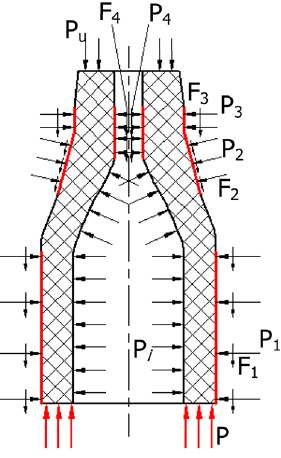
Fig. 10 Force diagram after rubber sleeve setting